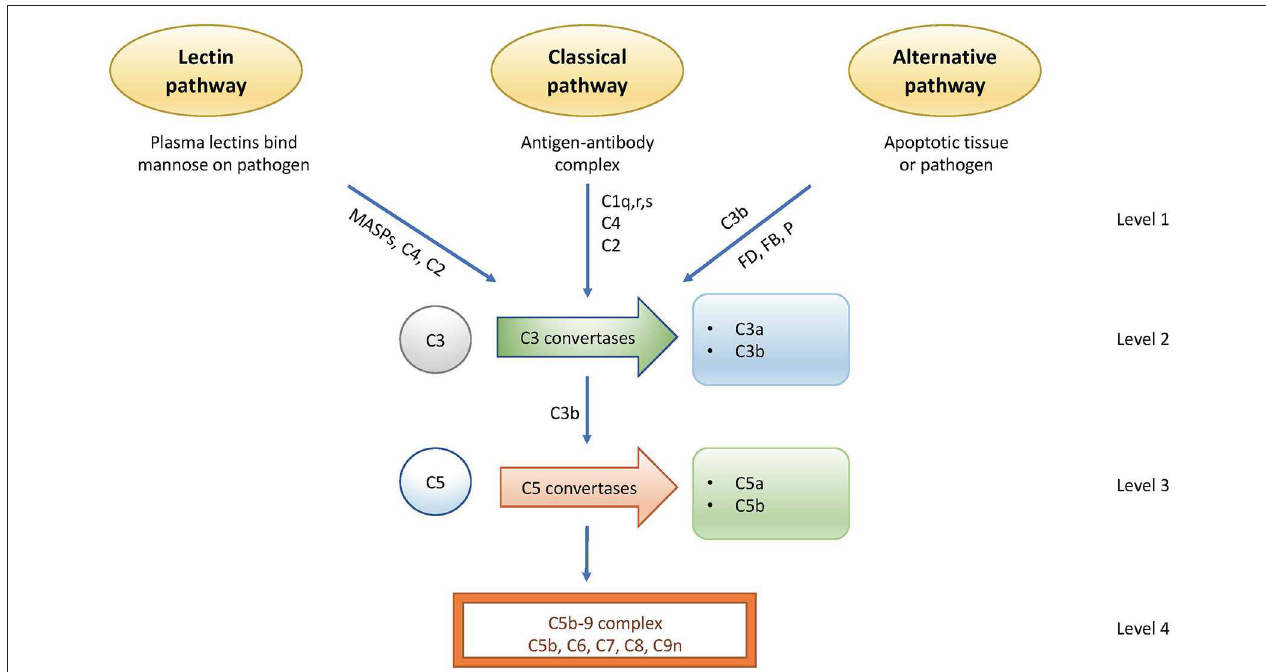
FIGURE 1 | Activation and regulation of the complement system. Activation occurs via the lectin pathway (LP), the classical pathway (CP), and the alternative pathway (AP). Regulation occurs at distinct points. Level 1: inhibition of proteases generated by the LP and AP; level 2: control of the C3 convertases; level 3: control of the C5 convertases; level 4: control of the formation of the C5b-9 complex of the terminal pathway (TP).